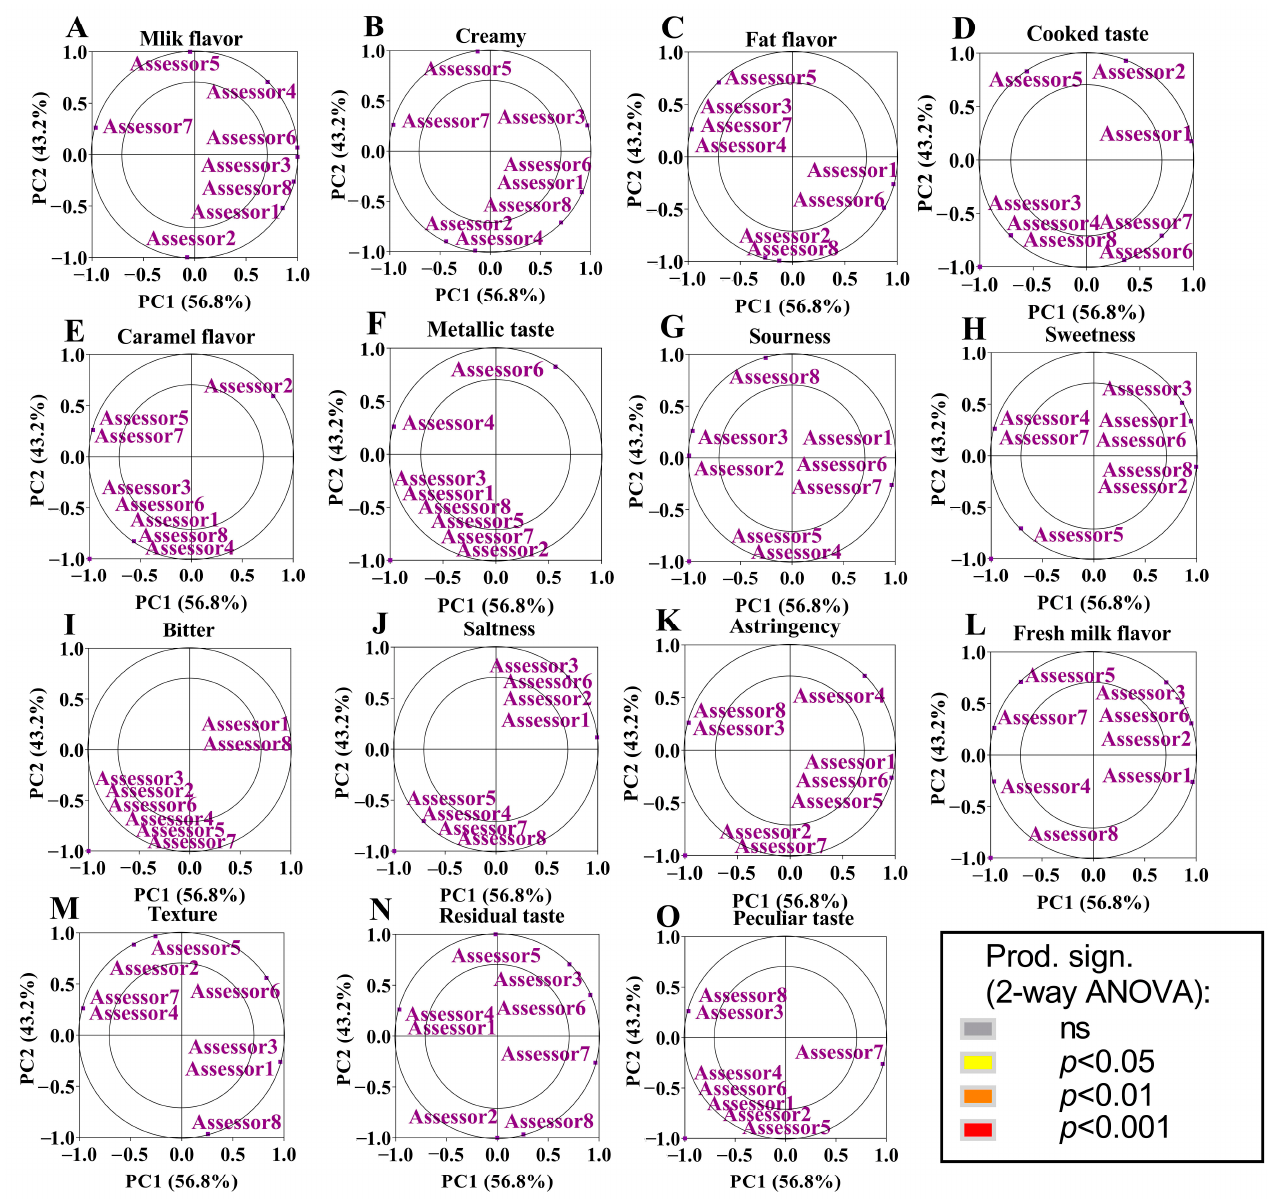
Figure 1. Checking the consistency of sensory evaluation group using Tucker-1 analysis for milk samples stored for 8 h. There were eight assessors and 15 flavors in total. ( A ) Milk flavor; ( B ) Creamy; ( C ) Fat flavor; ( D ) Cooked taste; ( E ) Caramel flavor; ( F ) Metallic taste; ( G ) Sourness; ( H ) Sweetness; ( I ) Bitter; ( J ) Saltness; ( K ) Astringency; ( L ) Fresh milk flavor; ( M ) Texture; ( N ) Residual taste; ( O ) Peculiar taste. A p < 0.05 was considered statistically significant. ’